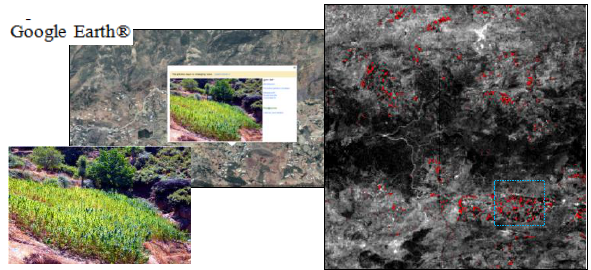
Figure 7. Cannabis data detection in Moroccan Hyperion data in